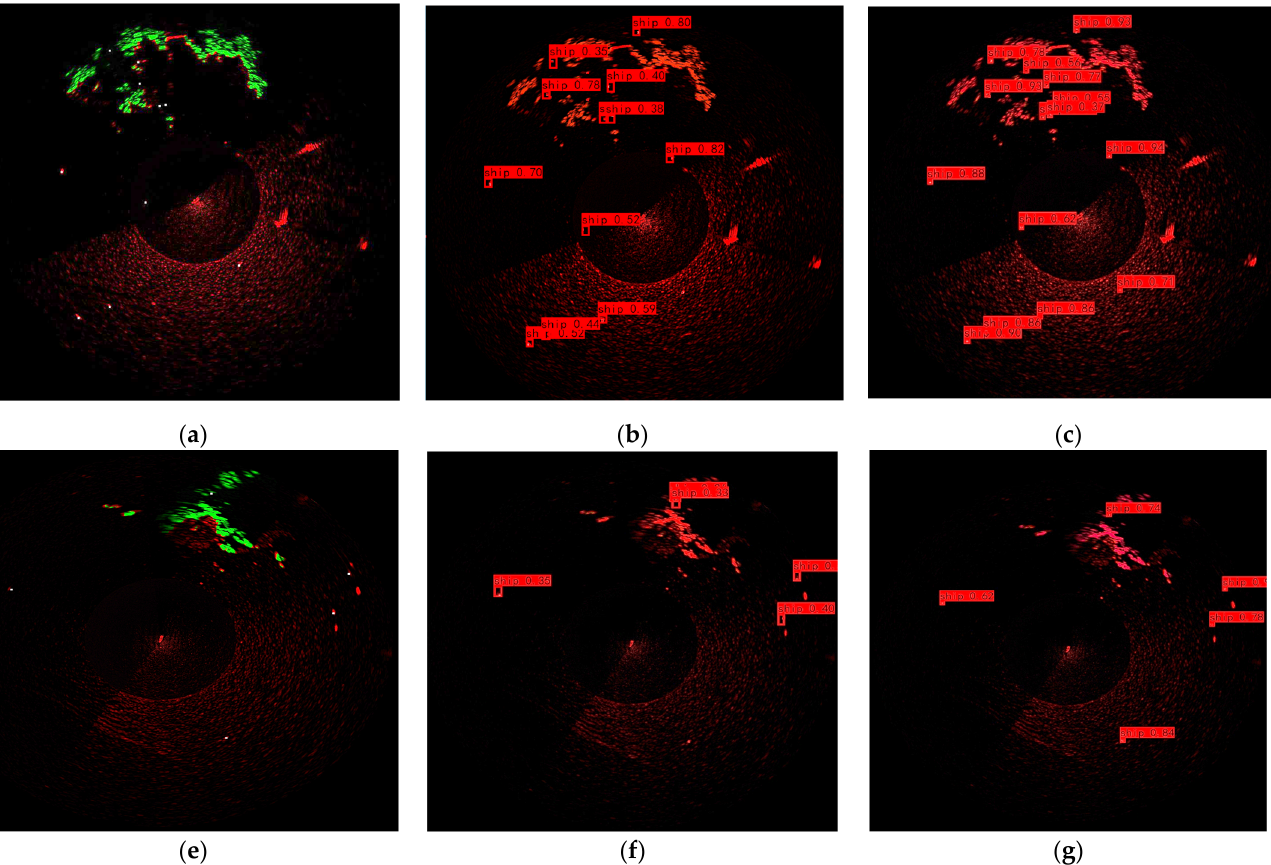
Figure 12. Detection results of Faster R-CNN and radar-PPInet for a single radar PPI image: ( a ) Original coastal PPI image; ( b ) Faster R-CNN; ( c ) Radar-PPInet; ( d ) Original open sea PPI image; ( f ) Faster R-CNN; ( g ) Radar-PPInet.